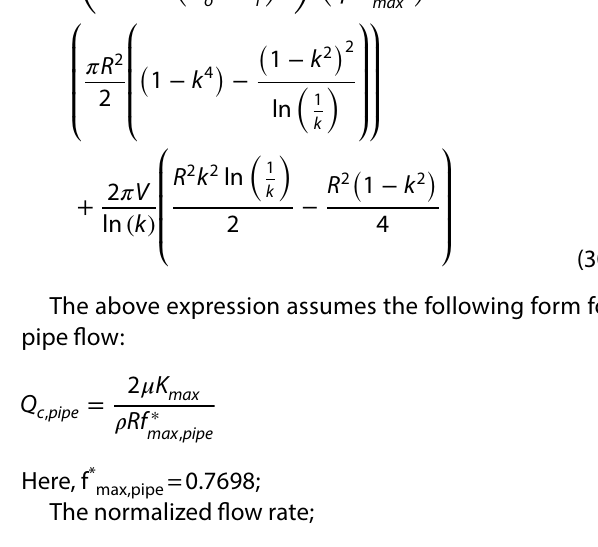
Length of planes